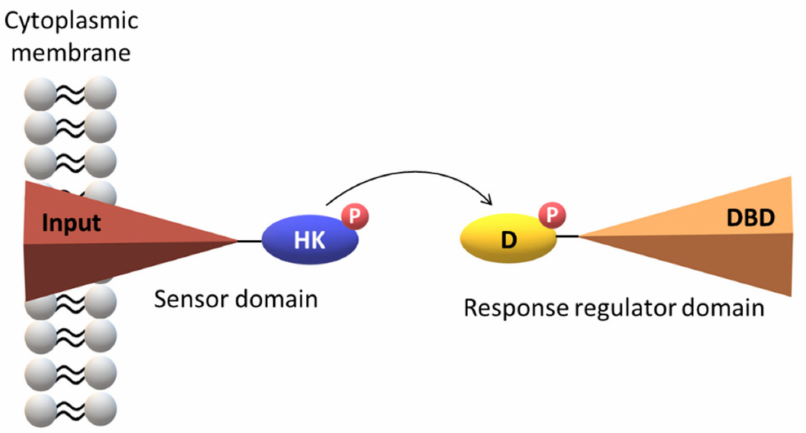
Figure 1. Simplified scheme for a two-component system. The histidine kinase (HK), the receiver— containing a specific aspartate residue (D)—and the DNA-binding (DBD) domains are